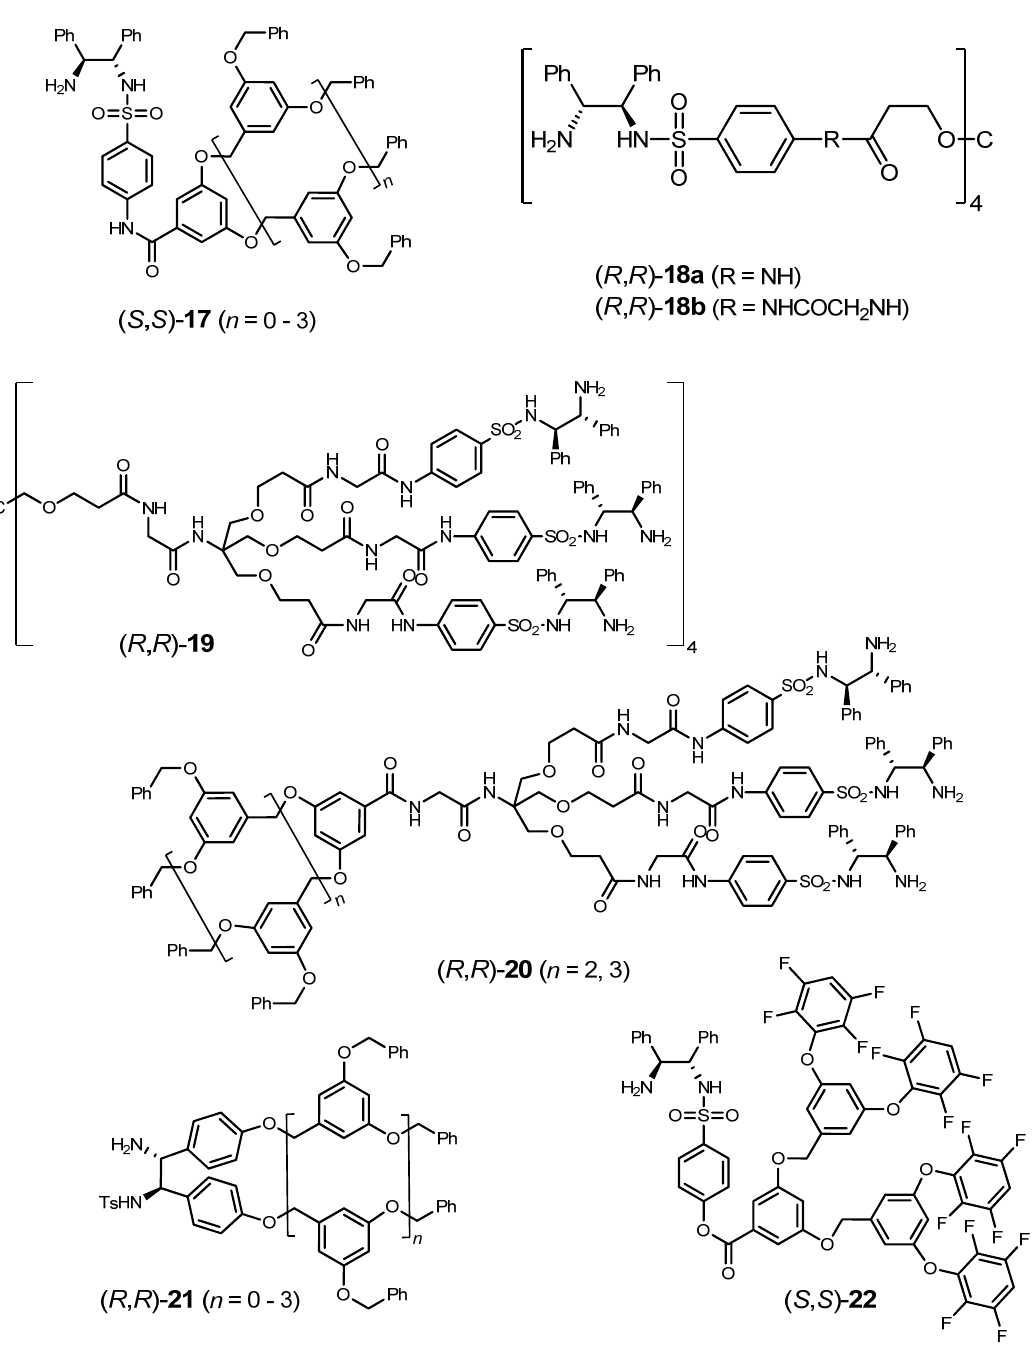
Figure 5. Dendritic TsDPEN-based